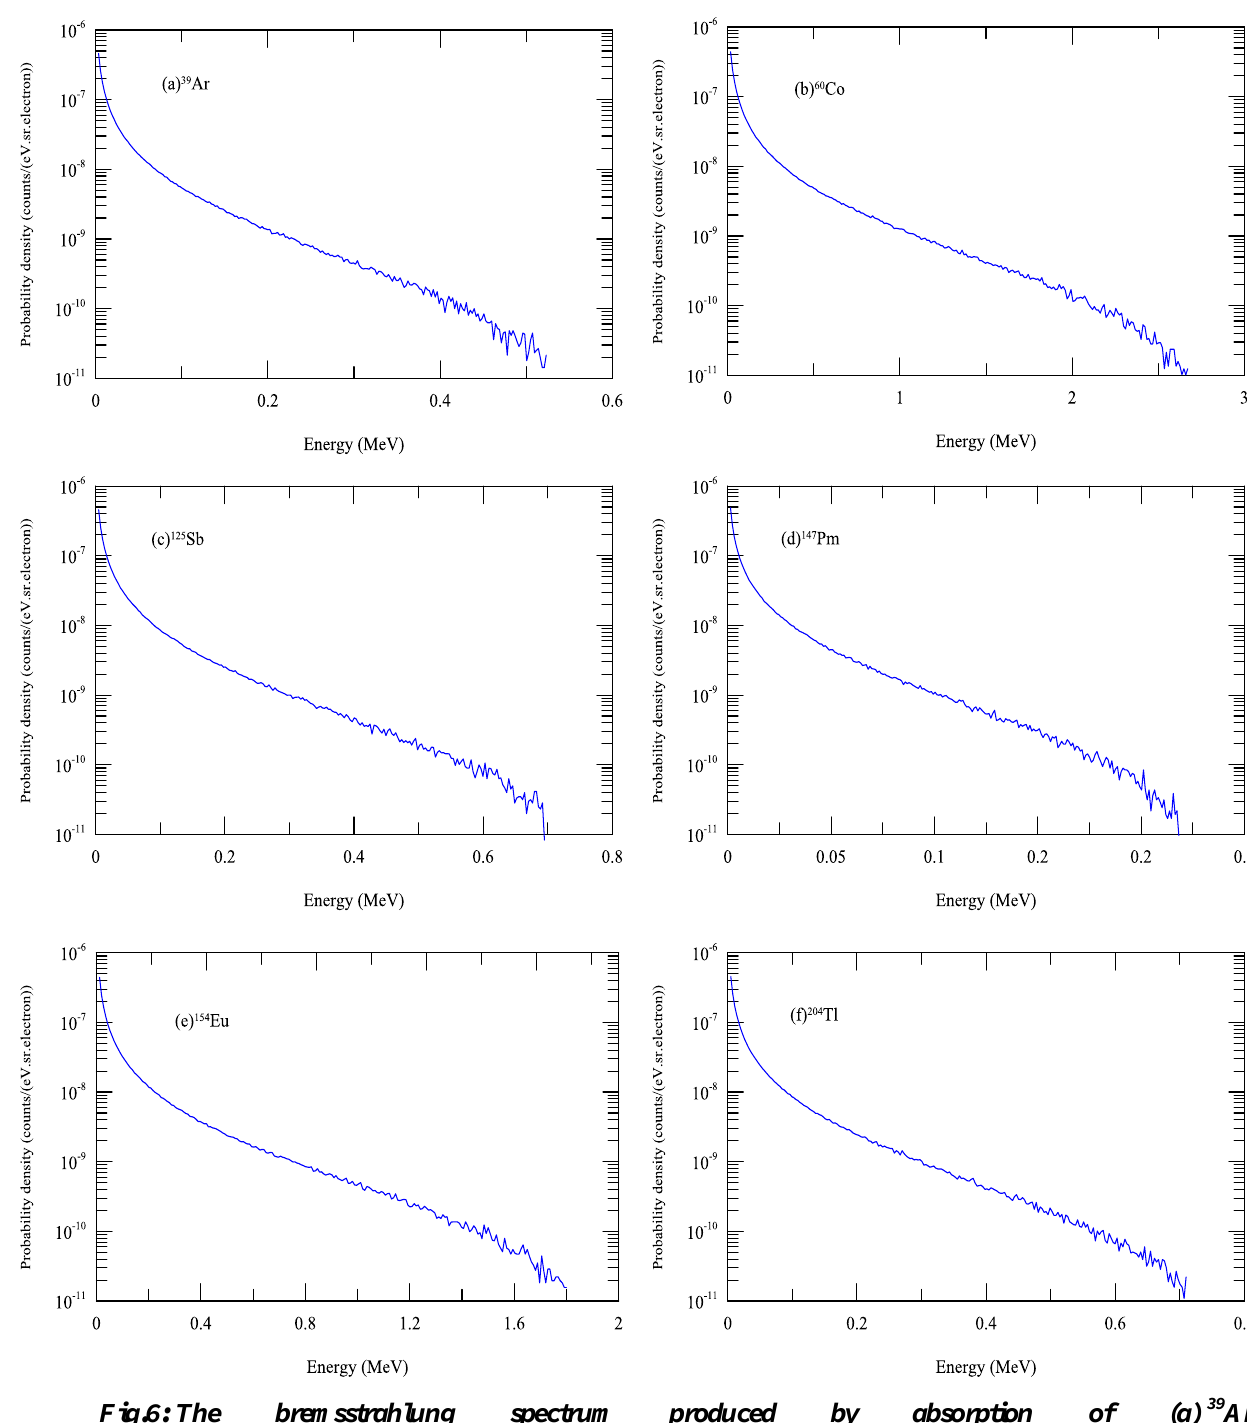
Fig.6: The bremsstrahlung spectrum produced by absorption of (a) 39 Ar, (b) 60 Co, (c) 125 Sb, (d) 147 Pm, (e) 154 Eu, and (f) 204 Tl beta particles into silicon